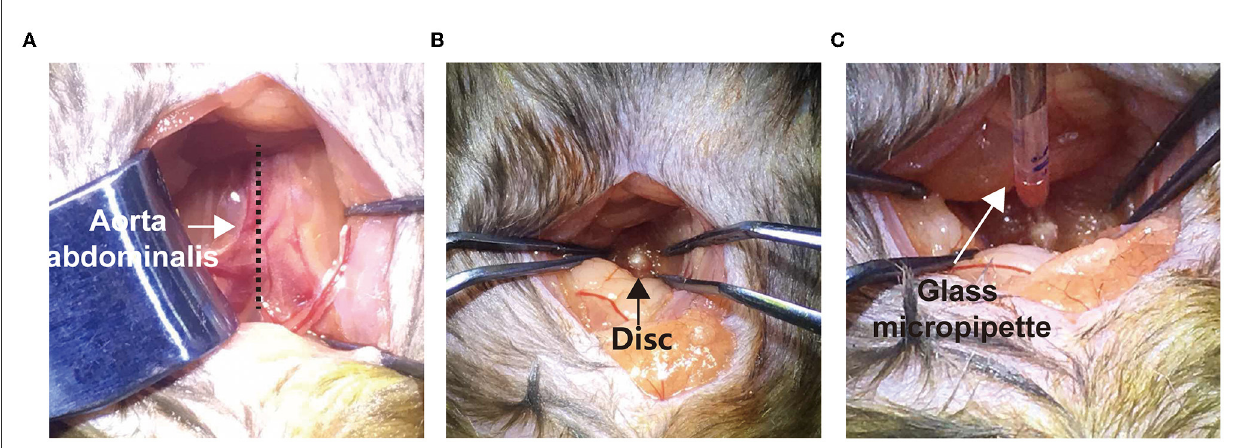
FIGURE1 Surgical procedure of disk microinjection through a transabdominal approach. (A) A middle longitudinal incision was made to expose the aorta abdominalis (arrow). The gut and caecum were gently pushed aside to expose the psoas muscles (dotted line). (B) Using smooth clamps, the L5/6 disk was further exposed (black arrow). (C) Using a glass micropipette and a nano-electronic microinjection pump, FG was slowly injected into the